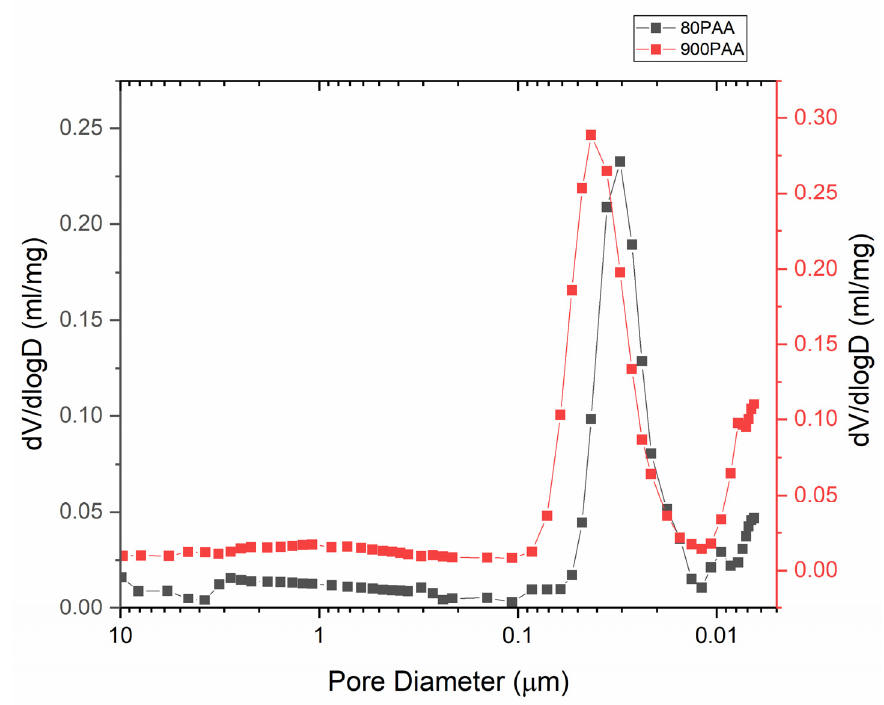
Figure 3. Pore size distribution in 90PAA and 80PAA samples.